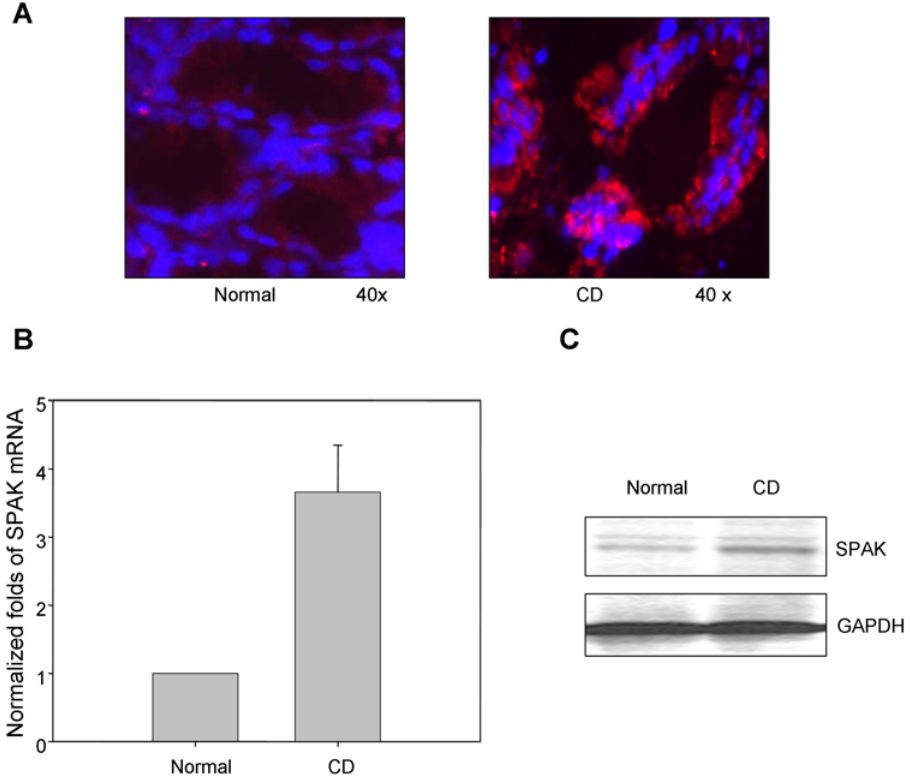
Figure 1. SPAK expression profile in colon tissue from patients with ulcerative colitis. A. Immunostaining of SPAK in normal human colon tissue and Crohn’s disease (CD) patient colon tissue from mucosal biopsies. SPAK expression (red); nuclear staining by DAPI (blue); SPAK is primarily expressed in epithelial cells. B. The expression of SPAK mRNA in normal human and Crohn’s disease (CD) patient colon tissues from mucosal biopsies were quantified by real-time PCR, ** p , 0.01. C. 30 m g of protein from normal human colon and Crohn’s disease (CD) patient colon from mucosal biopsies were examined by western blot with SPAK antibody, colon tissue from CD patients demonstrated significantly higher levels of SPAK expression (upper part) vs. healthy colon, with GAPDH as the internal loading control.